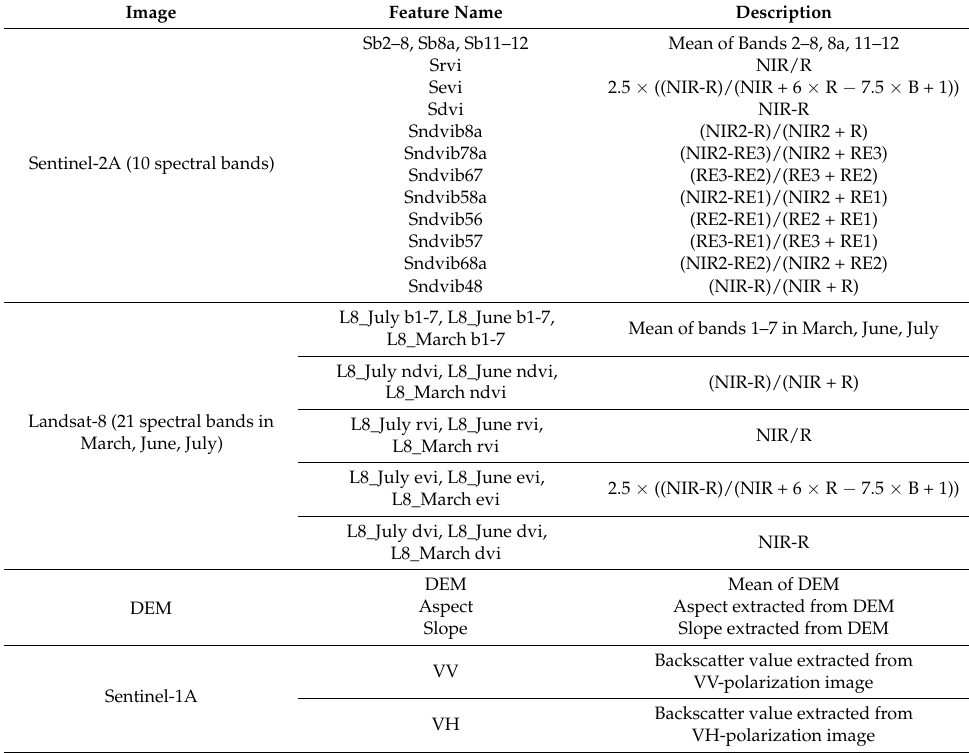
Table 7. Features derived from the multi-source images used in the Level-3